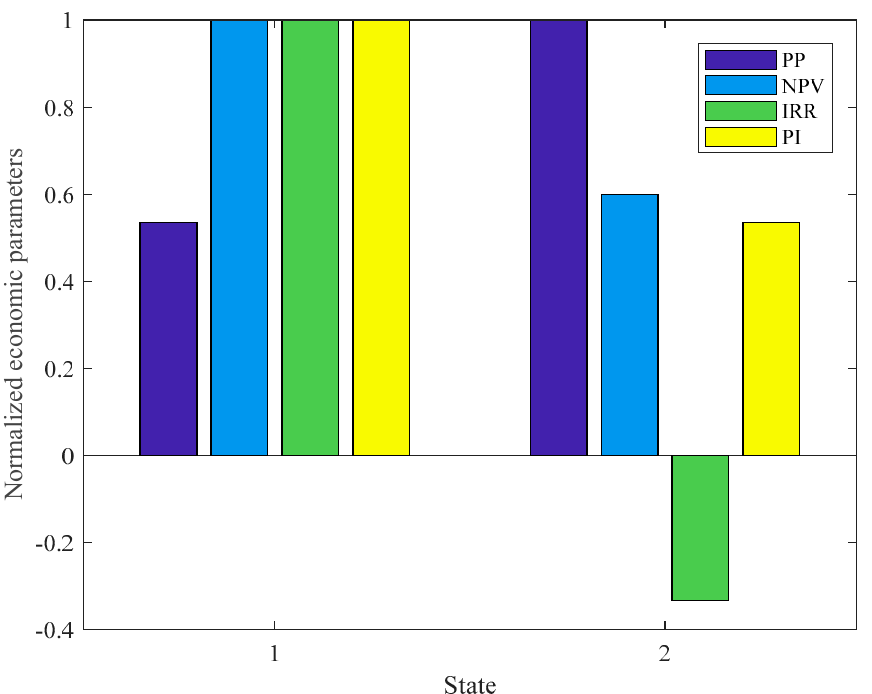
Figure 15. Comparing different buildings in the state B.